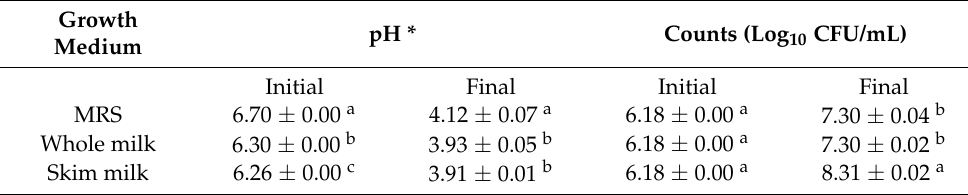
Table 2. Cell viability of Lactobacillus acidophilus in different culture media (media ± standard